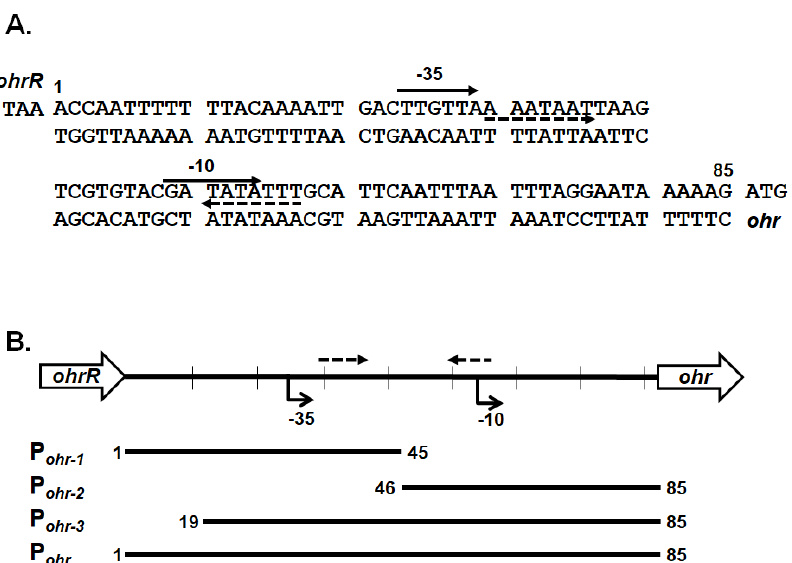
Figure 7. Genetic organization and intergenic sequences for chromosomal ohrR-C and ohr-C genes. ( A ) Intergenic sequences between the chromosomal ohrR-C and ohr-C genes. The numbers indicate positions relative to the stop codon of ohrR . Arrows with dashed lines indicate the putative inverted repeats. ( B ) Genetic organization and relative position of probes for EMSA.